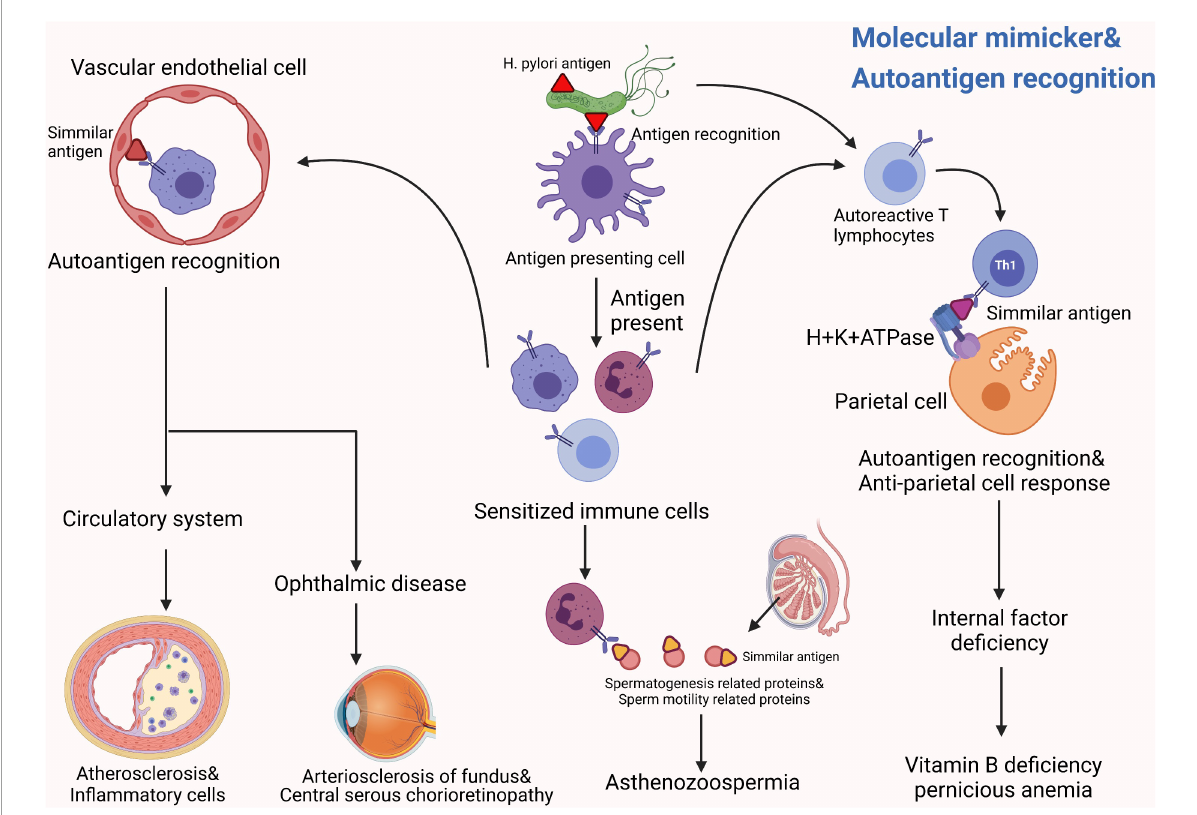
FIGURE4 The possible common mechanisms by which H. pylori induces these systemic diseases can be summarized into two promising hypotheses: Hypotheses 2. H. pylori antigen, like the antigen components of host leads to molecular mimicker and cross-antigen reactions, which cause autoimmune attacks and relevant diseases (Chmiela and Gonciarz, 2017). Typical diseases that chiefly rely on this mechanism include: a cross reaction between the CagA antibody and the vascular wall induces atherosclerosis (Guo et al., 2007); H. pylori and gastric H+K+ATPase cross antigen contributes to vitamin B12 deficiency (Claeys et al., 1998); arteriosclerosis of fundus for autoimmune reaction induces central serous choroidal retinopathy (CSR) (Franceschi et al., 2002); cross-antigen reactivity between spermatogenesis-related proteins, sperm motility related proteins and H. pylori contributes to hypomotility of sperm (Figura et al., 2002).